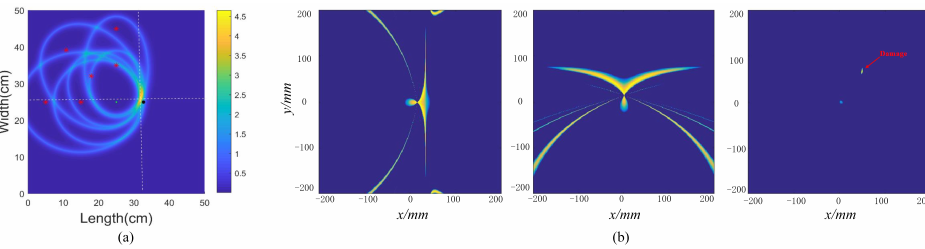
Figure 9. Geometric localization method based on laser ultrasonic Lamb wave. ( a ) Elliptical local- ization method [70]. ( b ) Hyperbolic localization images in both directions, and damage localization results after multiple image fusion [72].